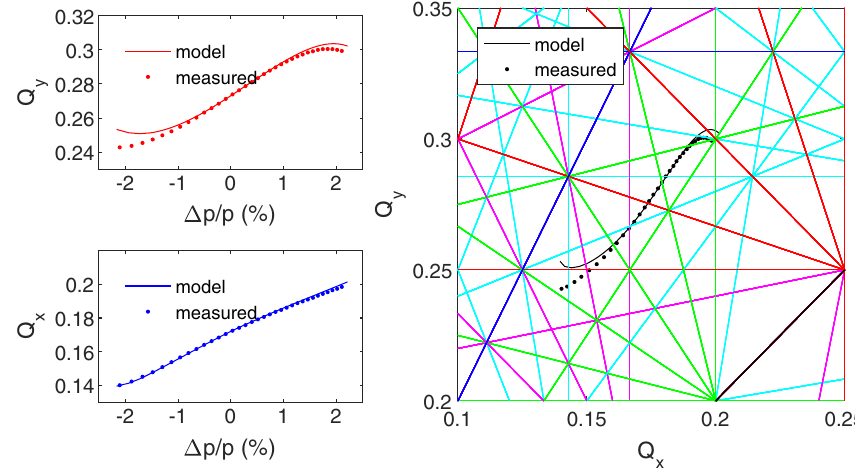
FIG. 6. Comparison of tune-shift with momentum between model and